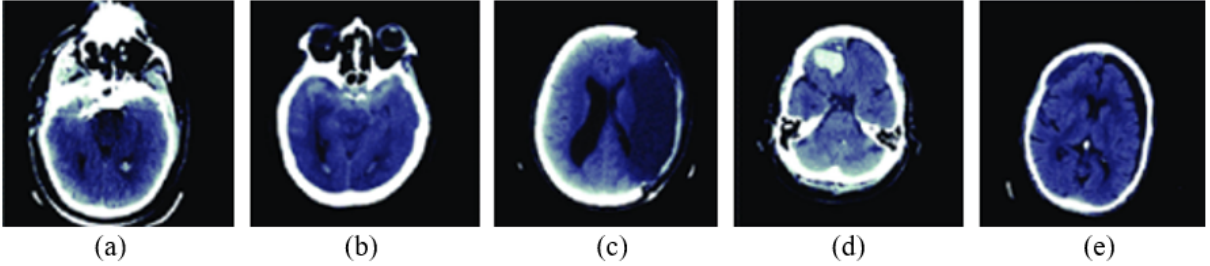
Figure 2. Sample acquired 3D brain scans, ( a ) intraparenchymal, ( b ) epidural, ( c ) intraventricular, ( d ) subarachnoid, and ( e ) subdural